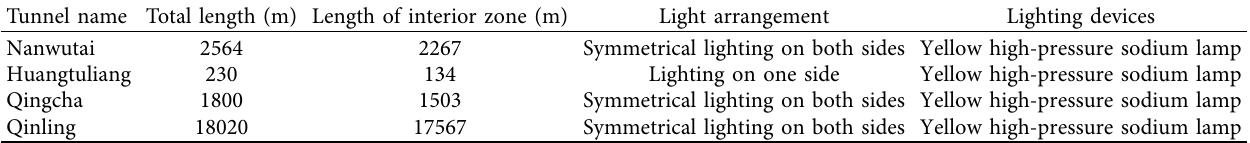
Table 1: Characteristic parameters of the tunnels.